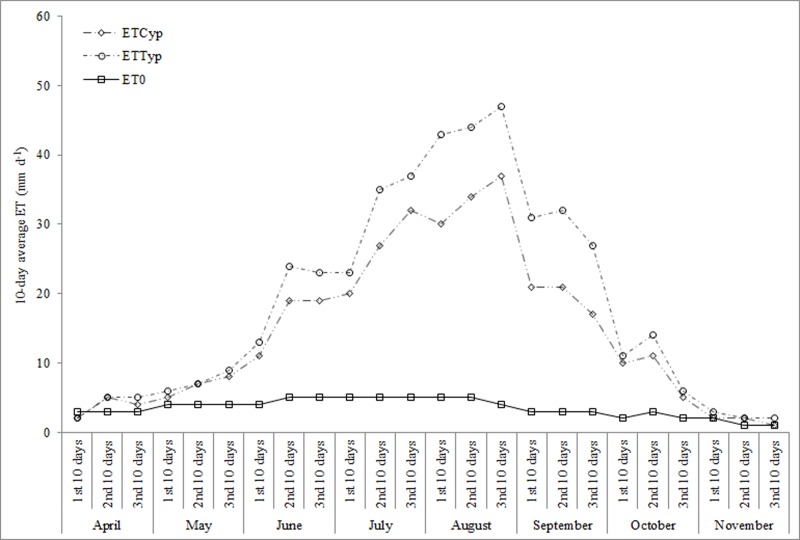
10 day-average ET0, ETtyp and ETcyp in HSSFs CW(1) during the test period.